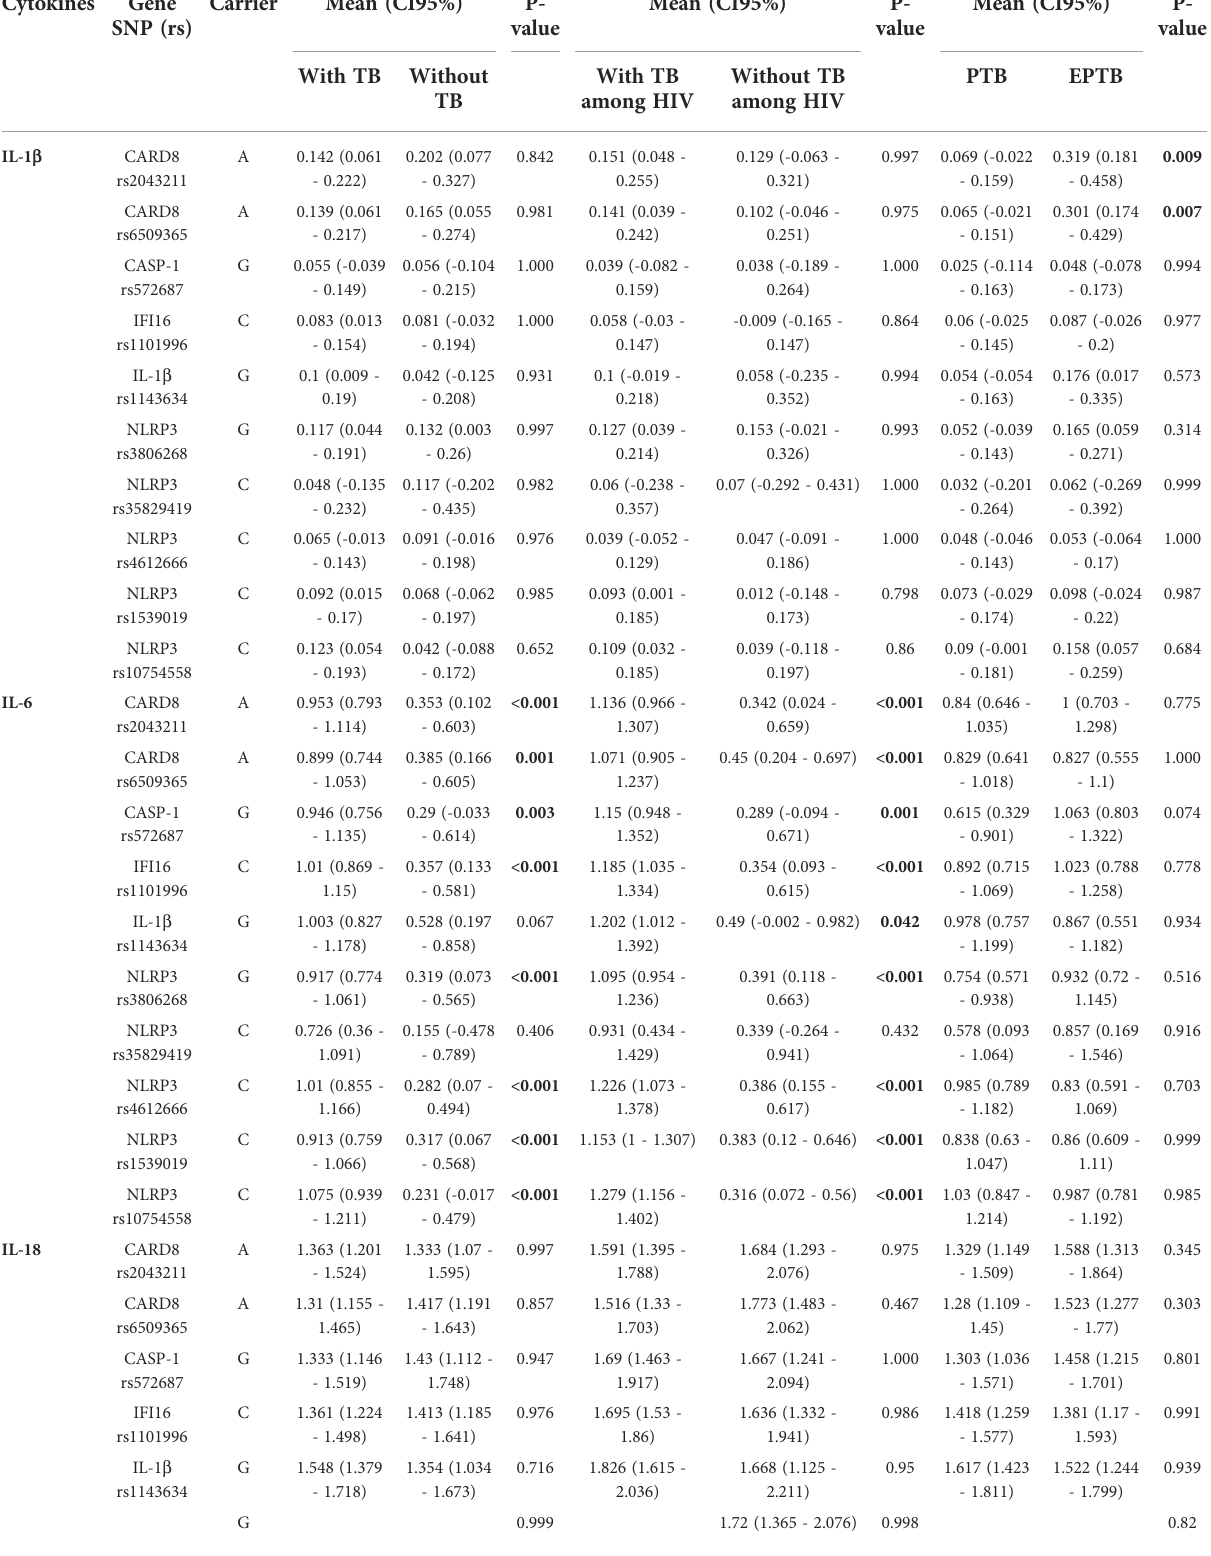
TABLE 4 Plasma levels of cytokines according to the evaluated SNPs of the individuals included in the study. Cytokines